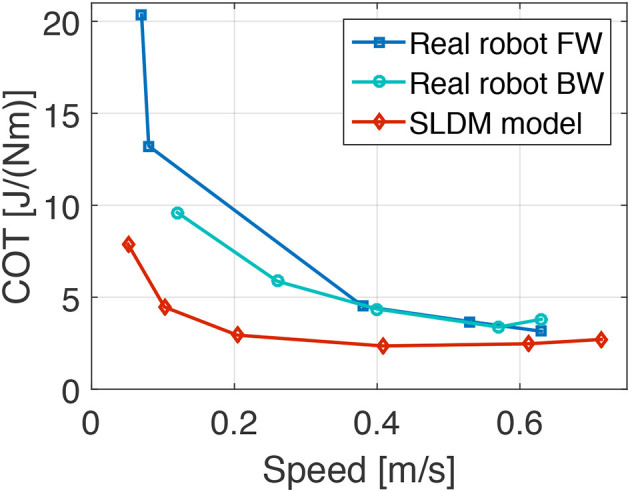
Hardware experiment and results from simplified-load dynamical motor (SLDM) model. Plots show the cost of transport (COT) of the real Oncilla robot and the SLDM model over different speeds. The full power consumption minus the stand-by robot power consumption (19.6 W) was used for the COT calculation. Red diamond (SLDM model) marks show the estimated COT values calculated prior to the construction of Oncilla robot based on a simplified, dynamically articulated robot model. Dark blue data points show the COT-speed values for the real Oncilla robot during level trotting in forward (FW) direction. Round marks indicate the hardware robot's COT during backwards (BW) level trotting. The FW locomotion shows a higher COT up to a speed of 0.4 m s-1, compared to the BW locomotion. The SLDM model continuously underestimates the real robot's COT, but provides a good estimate of the asymptotic decline of COT over speed. The best recorded COT with the real Oncilla robot is 3.2 J/(Nm) at 0.63 m s-1, during FW trotting.